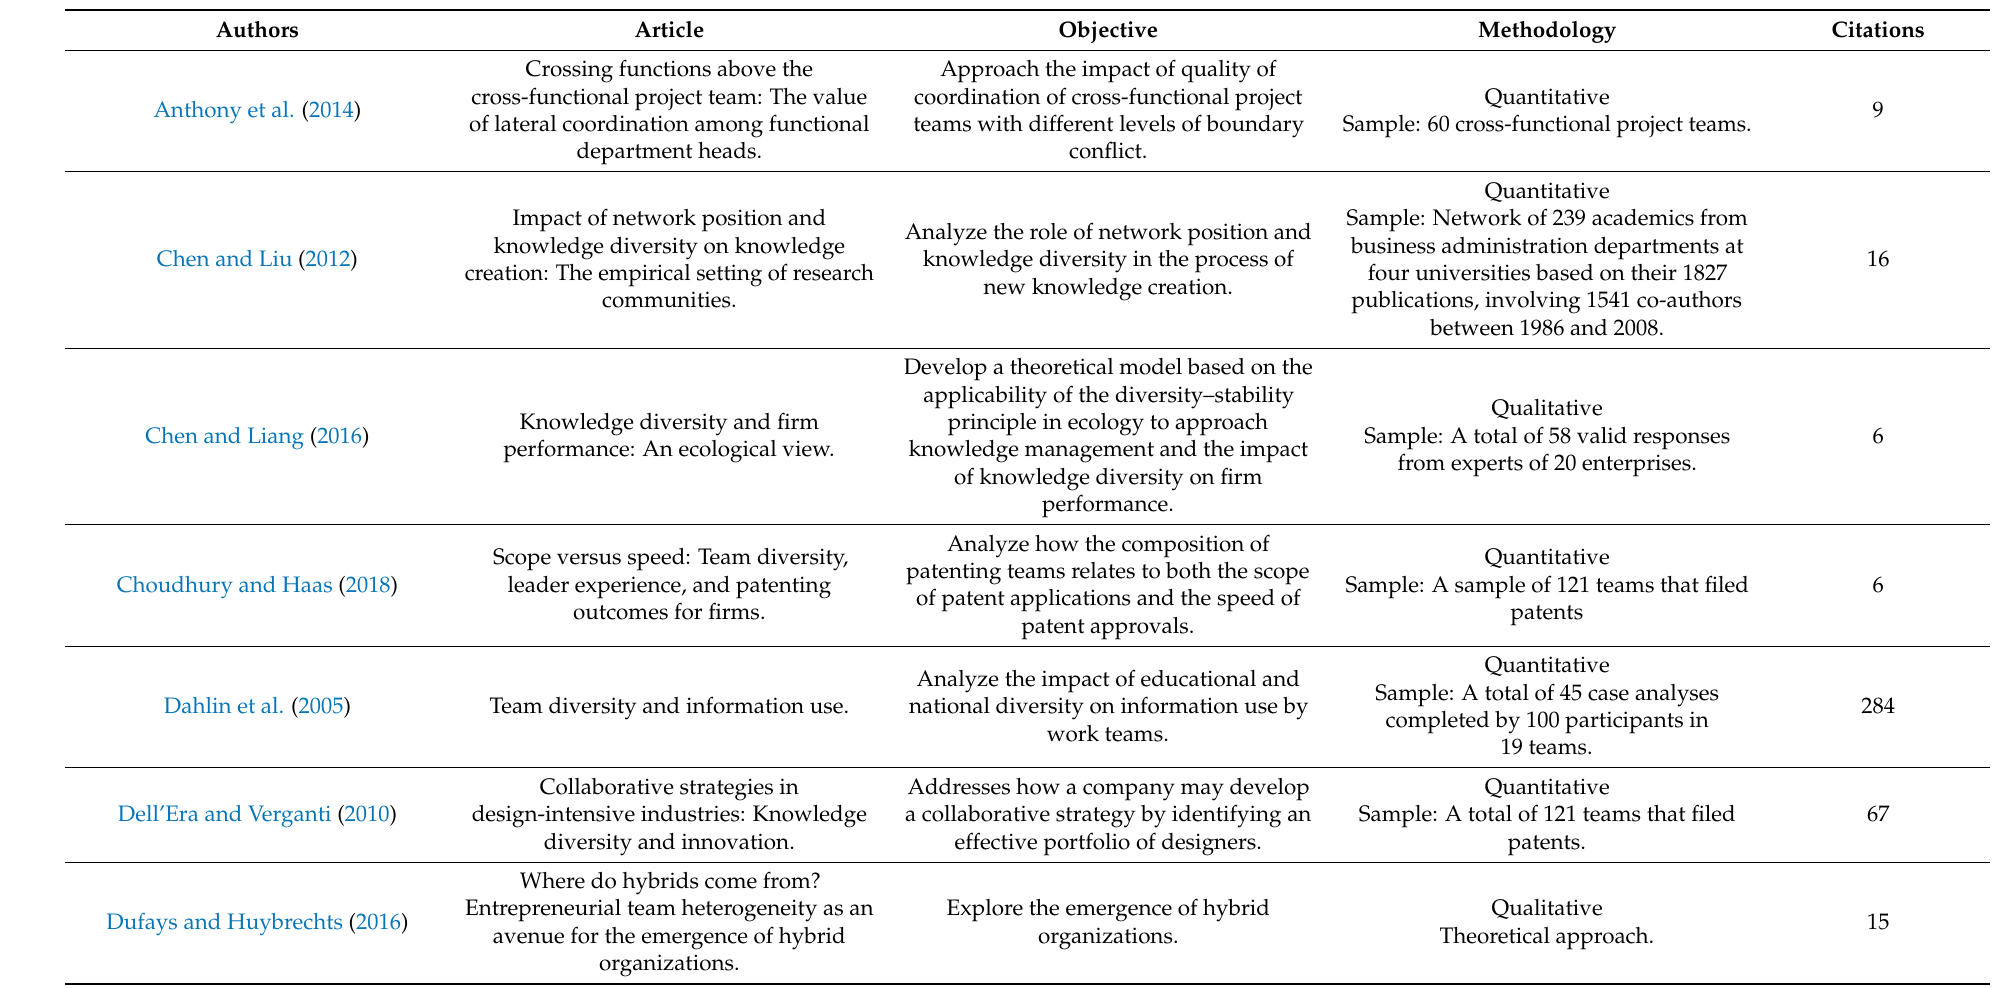
Table 4. Authors in Team knowledge Diversity